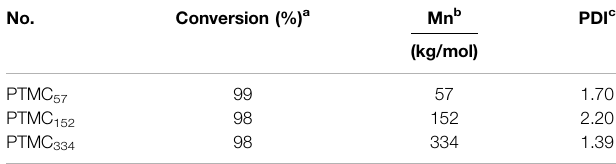
TABLE 1 | The characteristics of PTMC homopolymers.